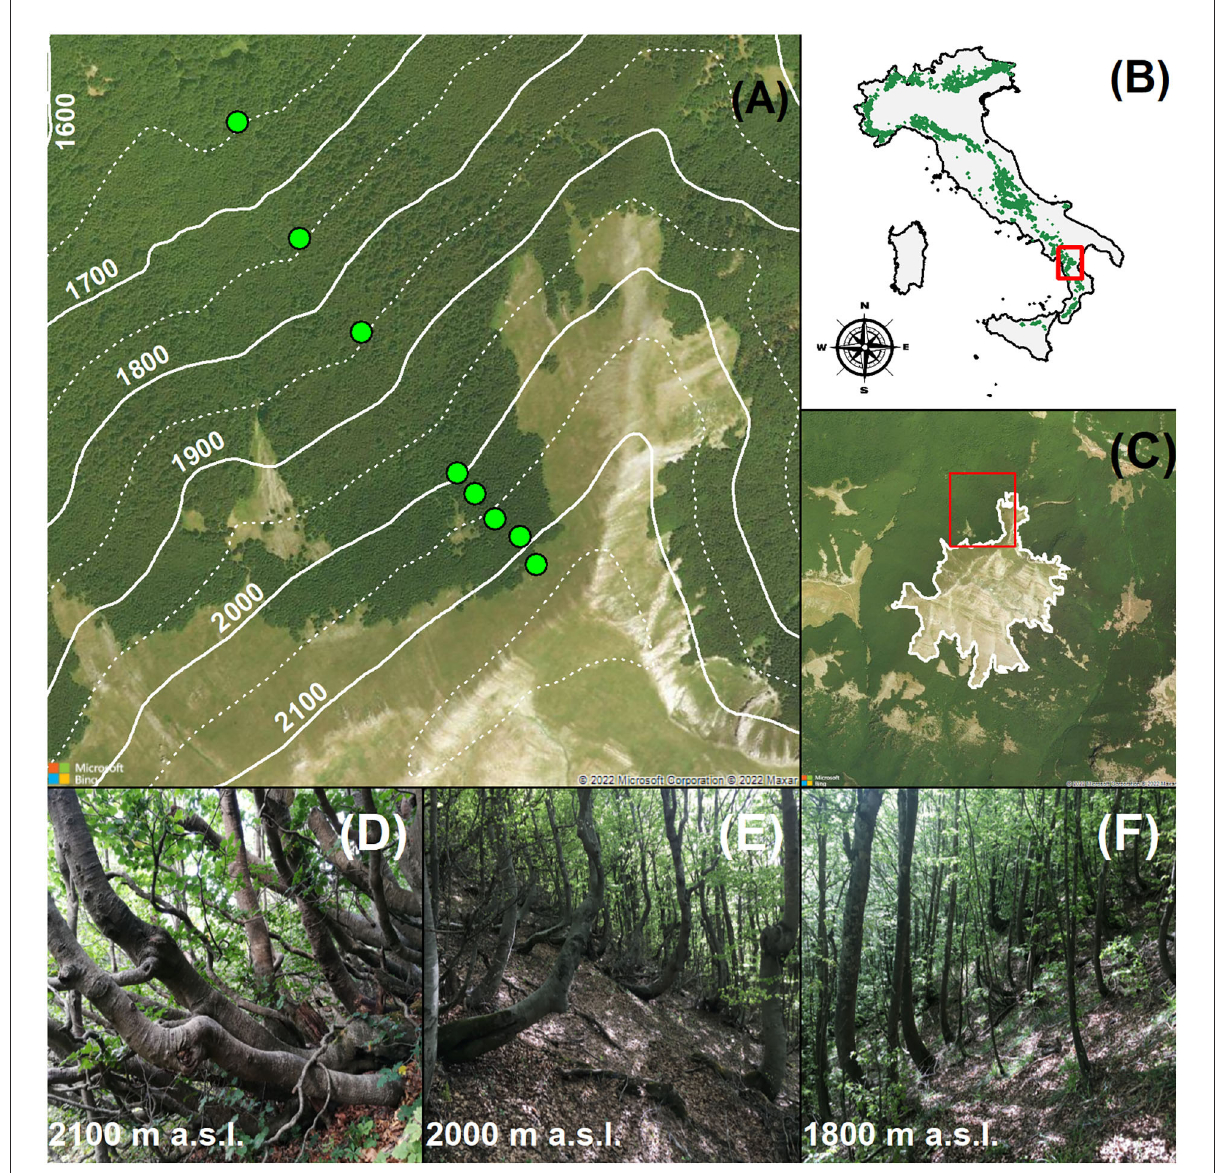
FIGURE1 High-elevation monospecific Fagus sylvatica forests in the Serra del Prete study area (southern Apennines, Italy). (A) Shows the north-western sampled slope of the mountain; the solid (100m) and dotted (50m) white contour lines represent elevation intervals; the green circular markers indicate the location of the permanent sampling plots ( n = 8). In (B) , the Alps and Apennines distribution range of F. sylvatica in Italy (IV level of Corine Land Cover) is indicated. In (C) , white lines denote the upper abrupt and “Krummholz” form ( sensu Harsch and Bader 2011), and red squares represent the spatial position of the north-western sampled slope of the Serra del Prete mountain. (D–F) Show the stand structure of F. sylvatica at 2,100, 2,000, and 1,800m a.s.l., respectively. The aerial images presented in this figure were obtained from Bing Maps (Microsoft ® Bing TM Maps API Platform).